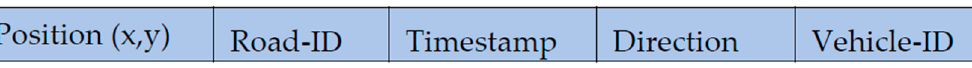
Figure 2. Information packet format.